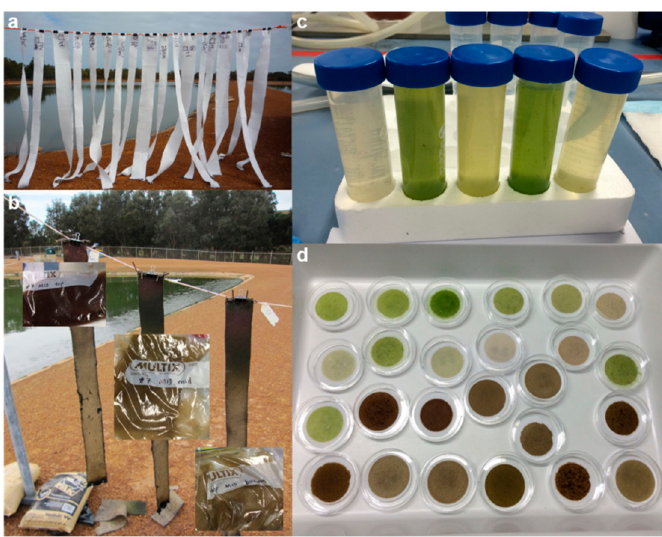
Figure 3. Process for selecting the material for the attached growth baffles used in this study. ( a ) Strips of different geotextiles were deployed in pond for two months, and then samples ( b ) were taken of each to determine which had the best adhesion ability. In determining best adhesion ability, samples were subject to ( c ) nutrient and chlorophyll- a analysis and ( d ) biomass analysis after